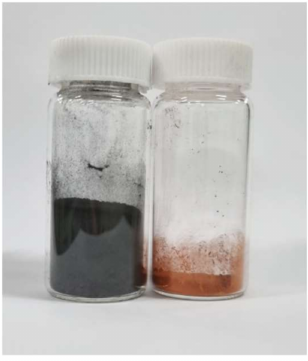
Figure 13. Image of the same weight of graphite and copper volumes (3